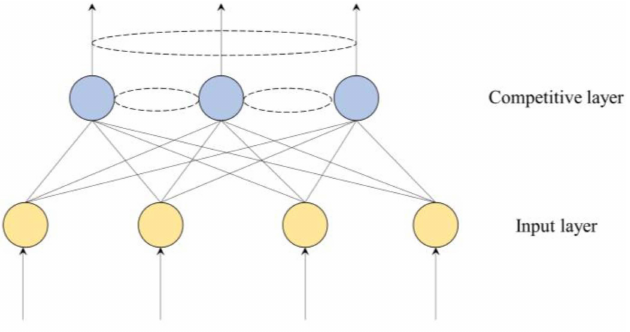
Figure 4. SOM network structure